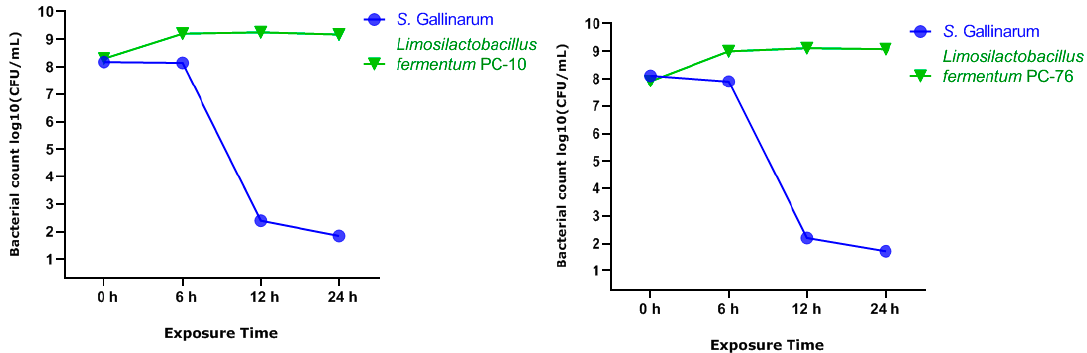
Figure 4. Enumeration of Salmonella Gallinarum and Limosilactobacillus fermentum PC-10 and PC-76 at specific times in co-culture assay.